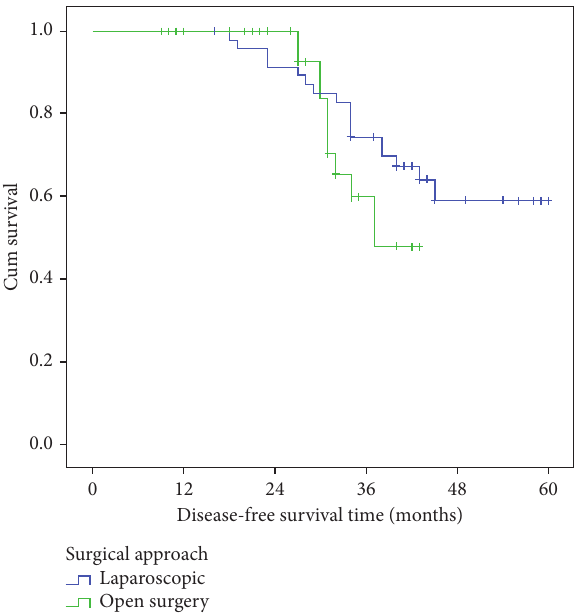
Figure 2: Kaplan–Meier survival function curve. It shows com- parable survival rates between the 2 study groups regarding relapse- free survival